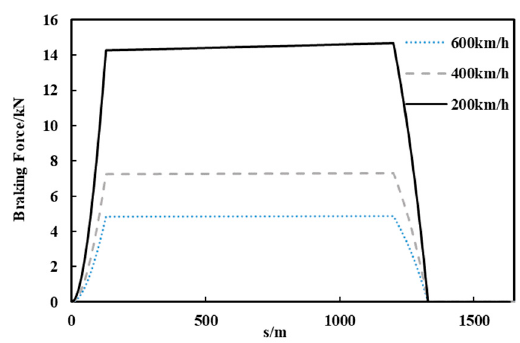
Figure 8. The braking force of one-side LLSM at different speeds.